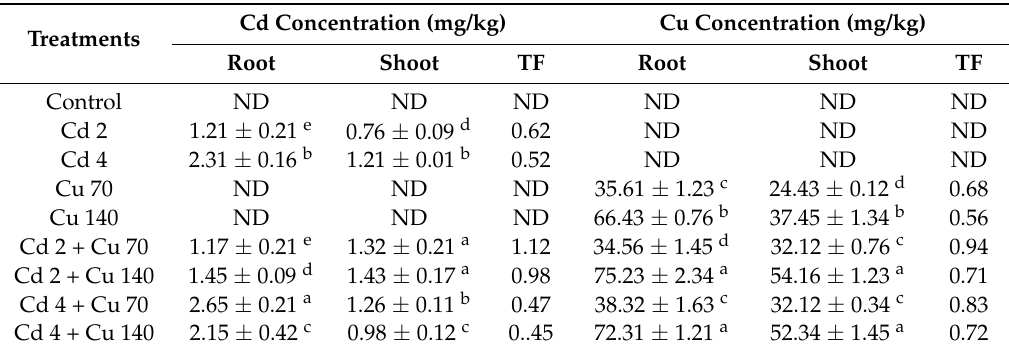
Table 3. Uptake and translocation factor (TF) of Cd and Cu in Gynura procumbens roots and shoot under different cadmium and copper treatments. ND = not